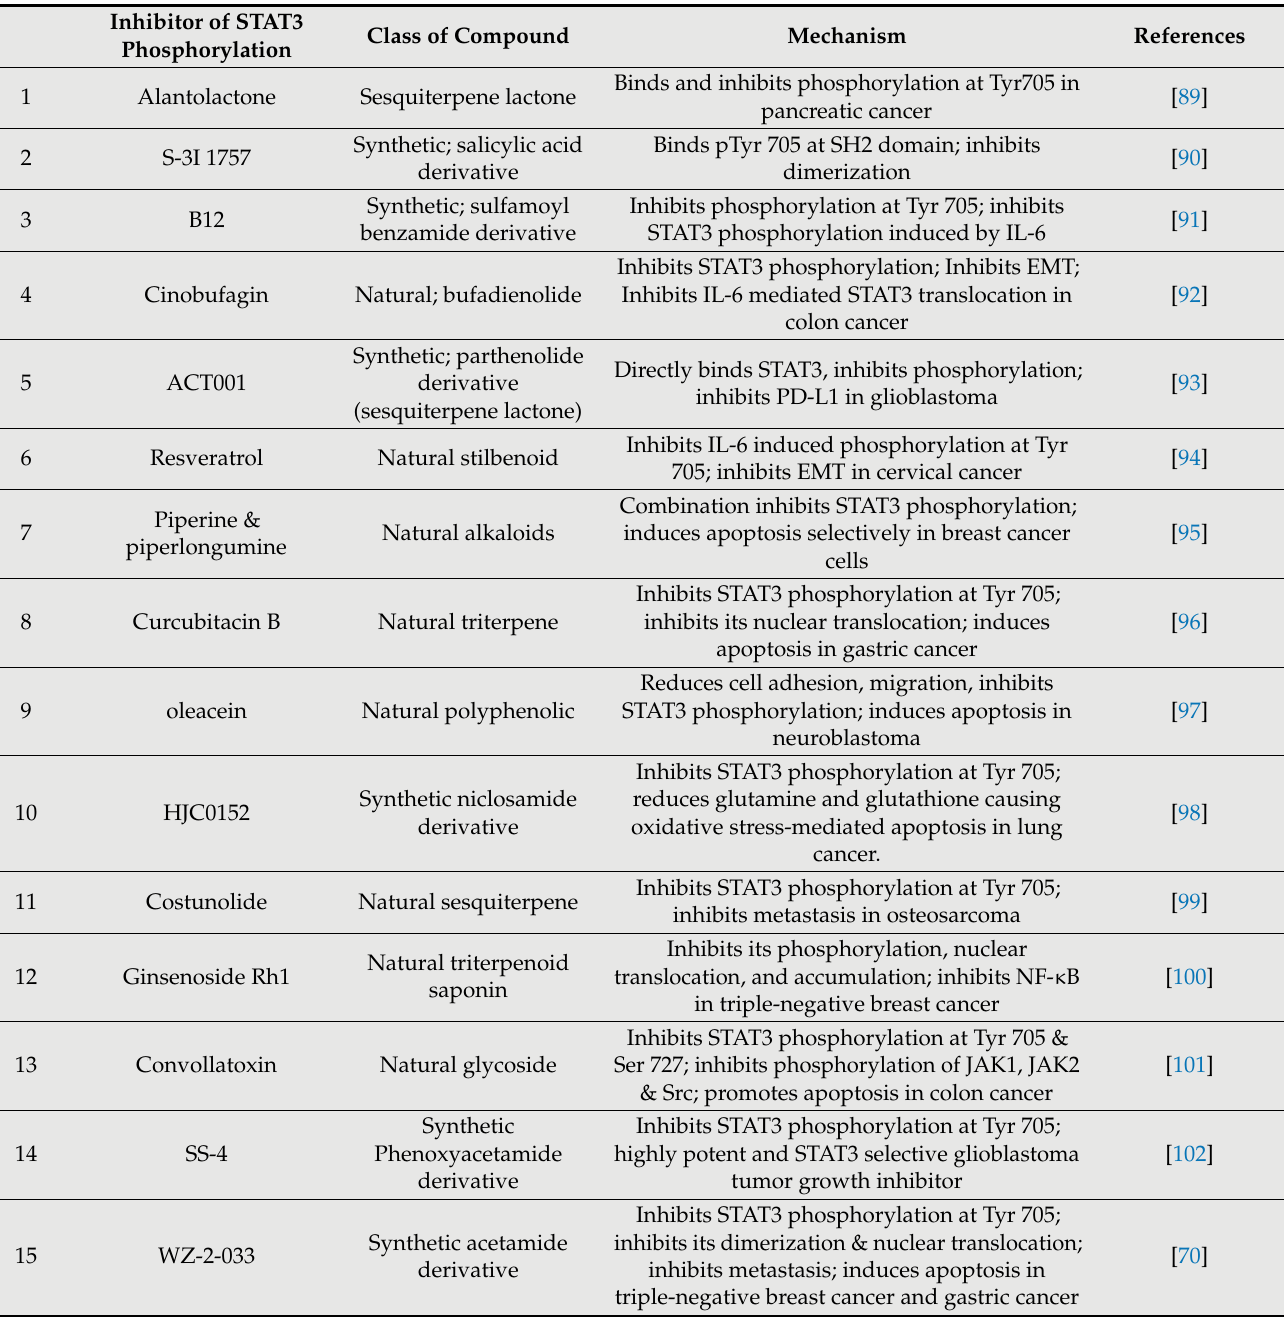
Table 1. Various natural and synthetic STAT3 antiphosphorylating